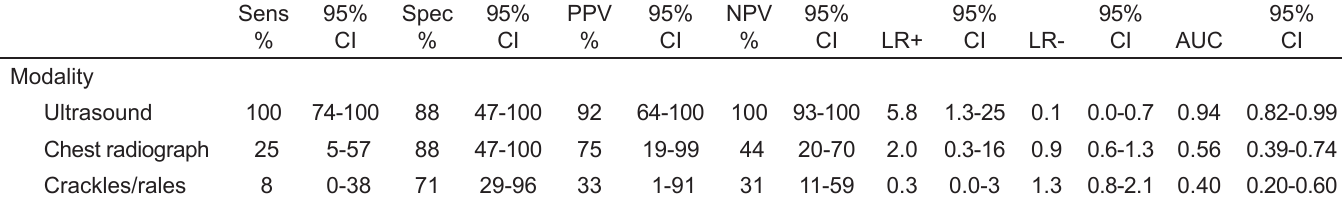
Table 2. Comparison of diagnostic performance of bedside point-of-care lung ultrasound, chest radiograph, and crackles on auscultation for diagnosis of lung involvement of SARS-CoV-2 using CT chest as the gold standard. These diagnostic performance characteristics are applicable only in the context of a patient who is symptomatic and was being specifically evaluated for COVID-19. Patients with known chronic heart failure and chronic lung disease, apart from asthma, have been excluded.